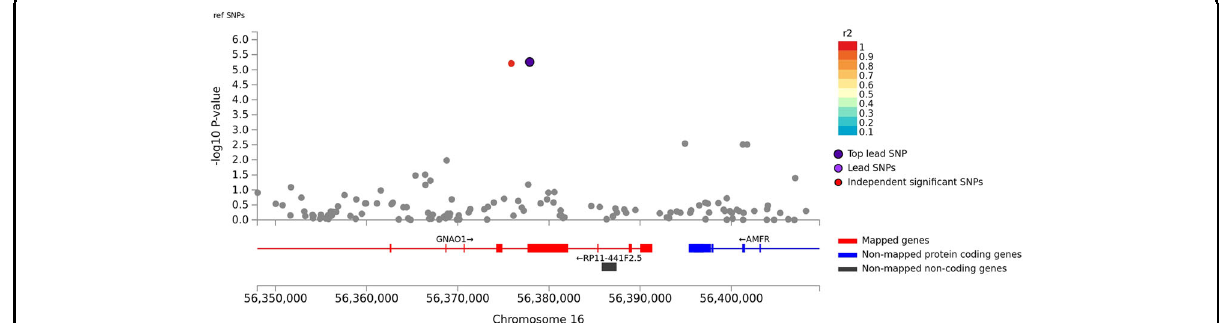
Fig. 4 Association of stimulant dependence with SNPs located in the GNAO1 region in the African American discovery sample. SNPs are color-coded according to the correlation coef fi cient ( r 2 ) in the 1000 Genomes African reference panel with the top-ranked SNP, rs116441240.